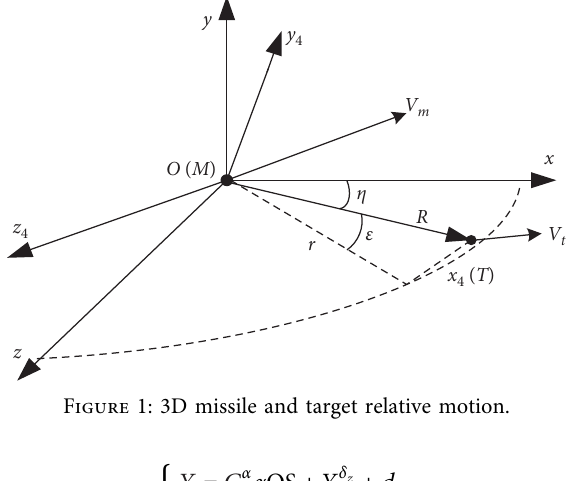
Figure 1: 3D missile and target relative